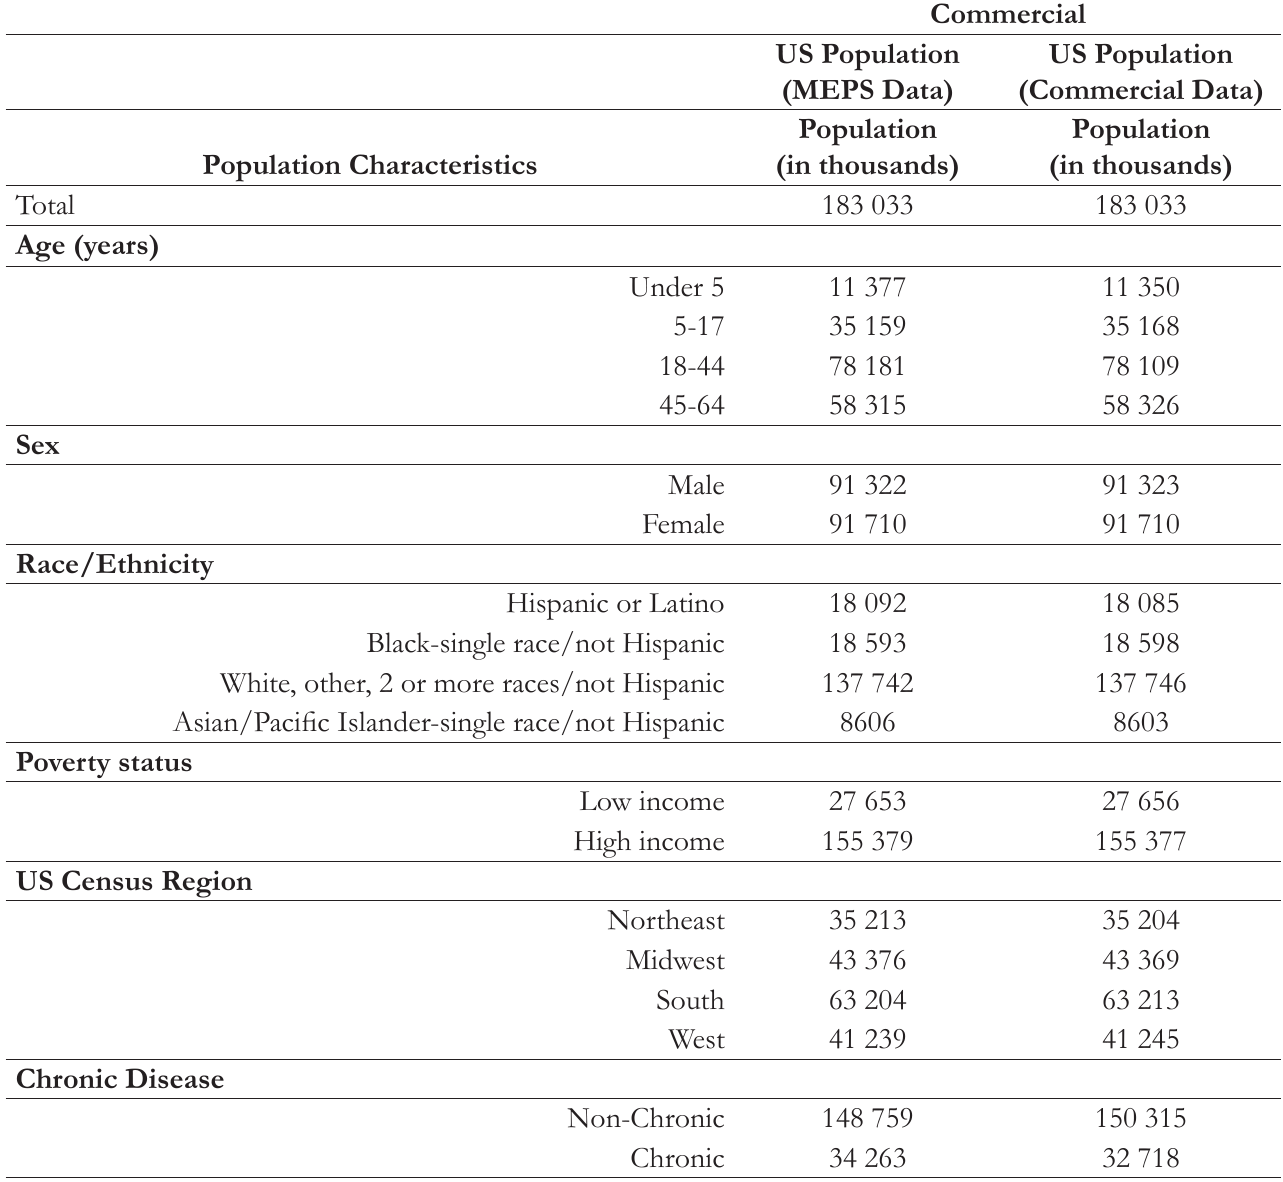
Table 3. Projected Number of People in the US Population using Commercial and MEPS Data